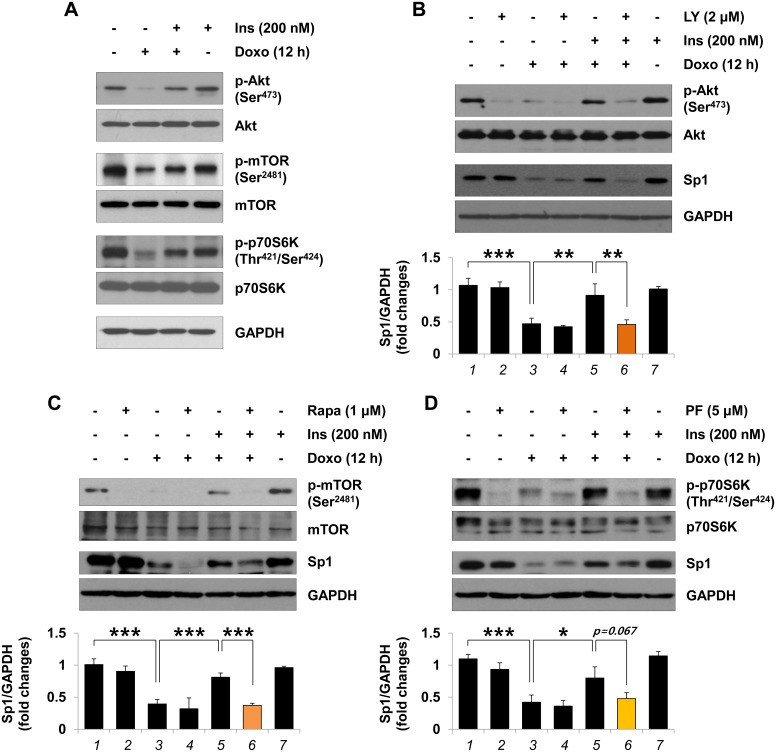
Inhibitory effect of insulin on the doxorubicin-induced Sp1 degradation via PI3K/Akt/mTORC1 pathway in H9c2 cardiac myocytes.(A) Serum-deprived H9c2 cardiac myocytes were left untreated or pretreated with 200 nM insulin (Ins) for 1 h and treated with 1 μM doxorubicin (Doxo) for 12 h. (B–D) Cells were pretreated with 2 μM PI3K inhibitor LY294002 (LY) (B), 1 μM mTORC1 inhibitor rapamycin (Rapa) (C), or 5 μM p70S6K inhibitor PF4708671 (PF). (D) for 1 h, followed by treatment with insulin (200 nM) for 1 h and then with doxorubicin (1 μM) for 12 h. Whole cell lysates were analyzed by immunoblotting for protein levels or phosphorylation status of Akt, mTORC1 and p70S6K and for protein levels of Sp1 using antibodies listed in Materials and Methods. Note that these blots represent one of three independent experiments. Graphs represent the mean ±S.D. of the normalized densitometric analyses of Sp1 protein levels (*p < 0.05; **p < 0.01; ***p < 0.001, n = 3).